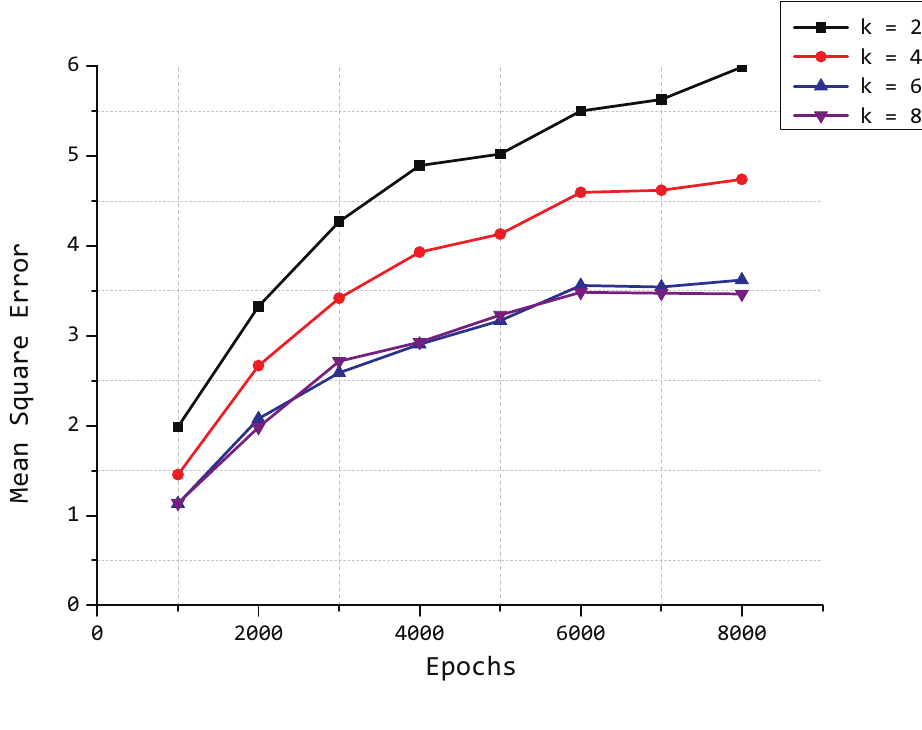
Figure 11. Mean square error for different values of k .